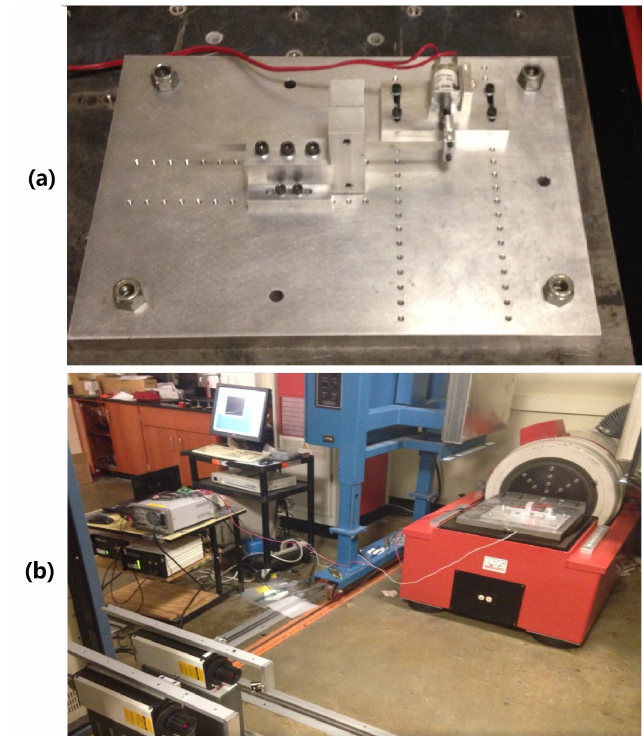
Figure 7. The test setup: ( a ) A solenoid to be tested mounted on a fixture. ( b ) The solenoid and fixture mounted on the vibration test system.